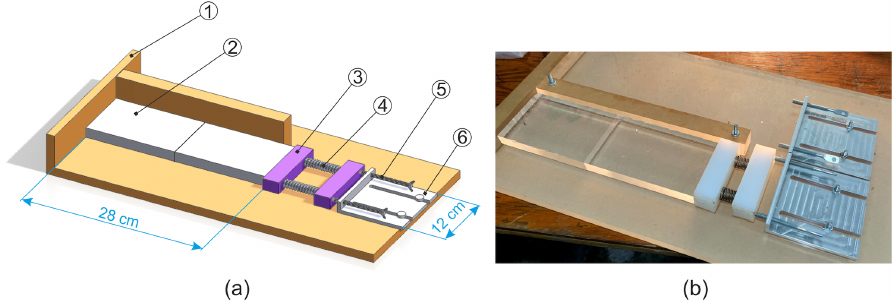
Figure 1. Sketch (a) and photograph (b) of the freeze-bonding rig with an ice sample having the shape of a thin plate: 1 – acrylic plate; 2 – ice specimen; 3 – plastic bar; 4 – spring; 5 – bolt; 6 – fixation